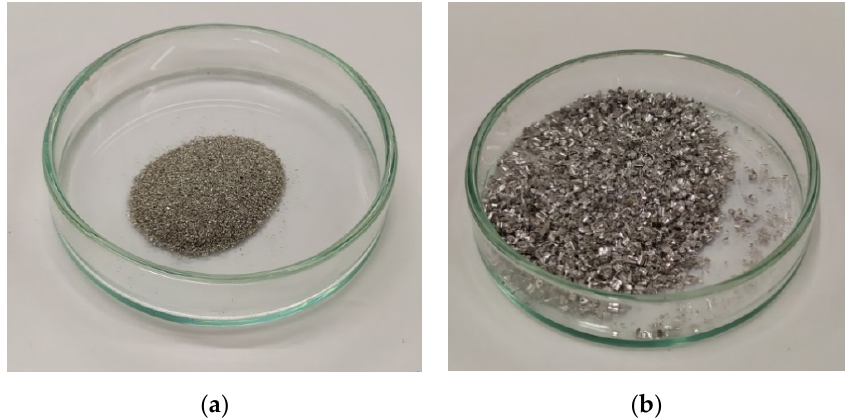
Figure 1. ( a ) magnesium in flakes with a granulation <0.25 mm, ( b ) magnesium in